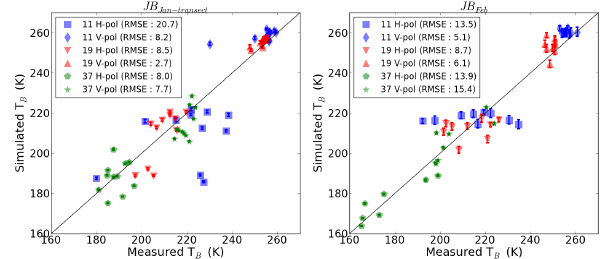
Figure 8. Sensitivity of snow-covered surface T B to the variation of soil roughness ( σ ) for (left) JB Jan-transect and (right) JB Feb . The error bars show the variation of T B for maximum and minimum optimized σ derived from SEex during both campaigns (Fig. 7). The RMSE (K) values correspond to the retrievals using the initial (Table 6) σ value.